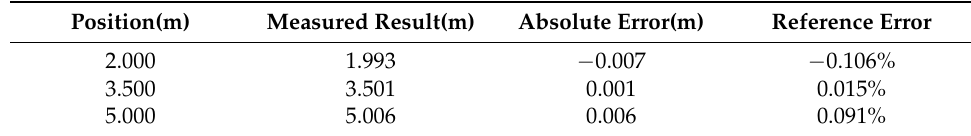
Figure 9. A photograph of the multi-point positioning measurement experiment. Table 2. Multi-point positioning measurement results.